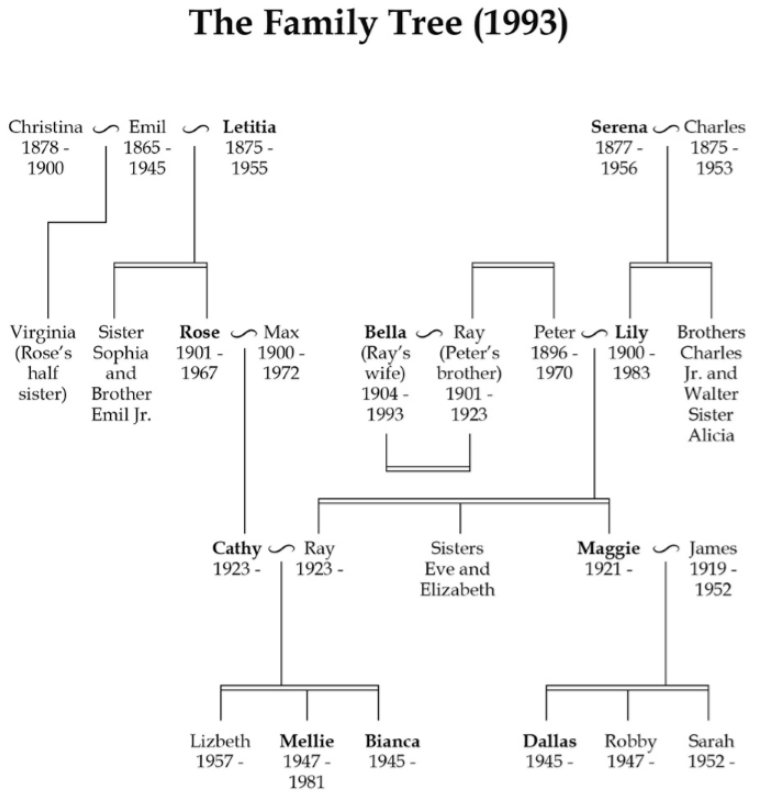
Figure 1. The Family Tree 1993.